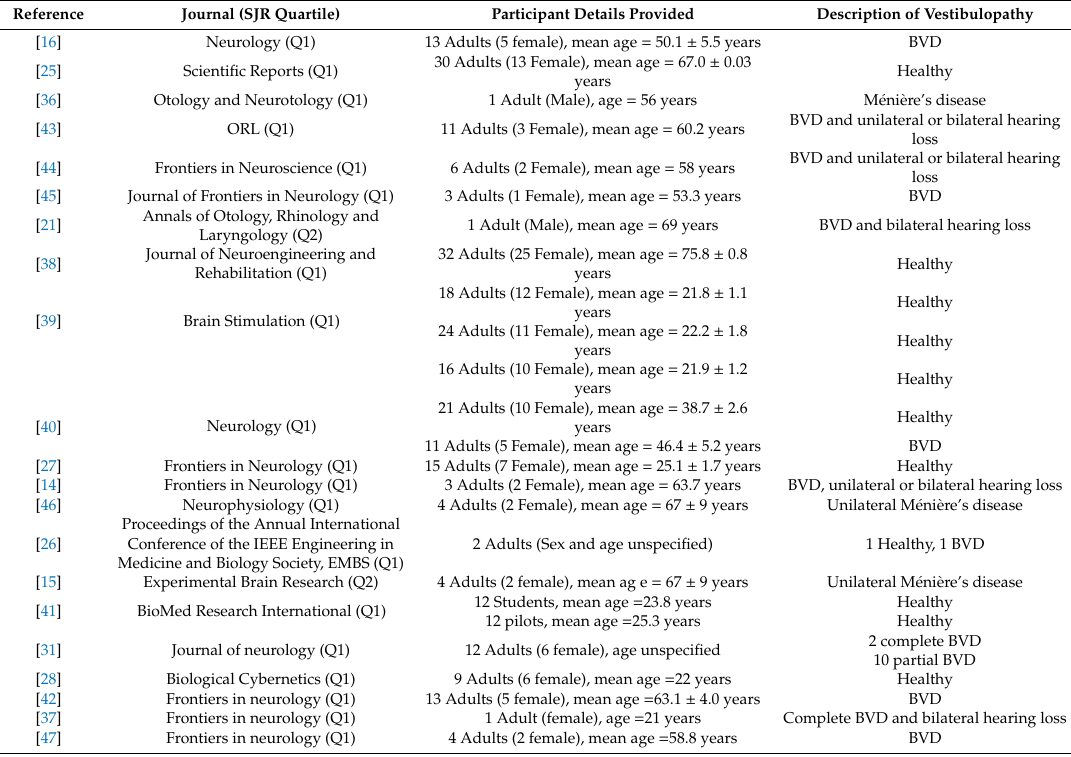
Table 2. A summary of the population characteristics and scientific journal impact of papers published investigating the e ff ect of artificial vestibular stimulation on behaviours related to balance control in